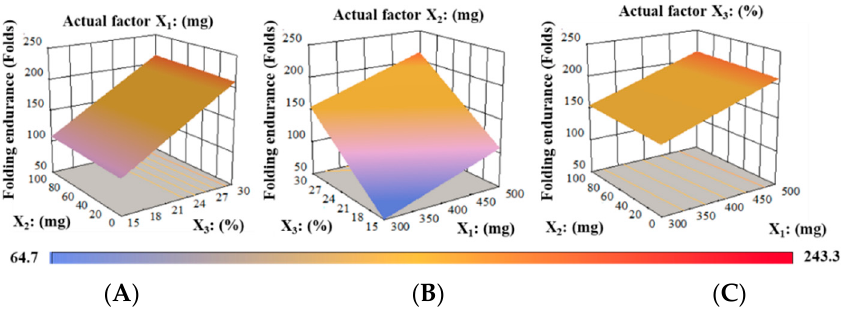
Figure 3. 3D surface models describing the influence of ( A ) PUL (X 1 ), ( B ) MTX (X 2 ), and ( C ) PG (X 3 ) on folding endurance (Y 2 ) of RZT-ODFs.